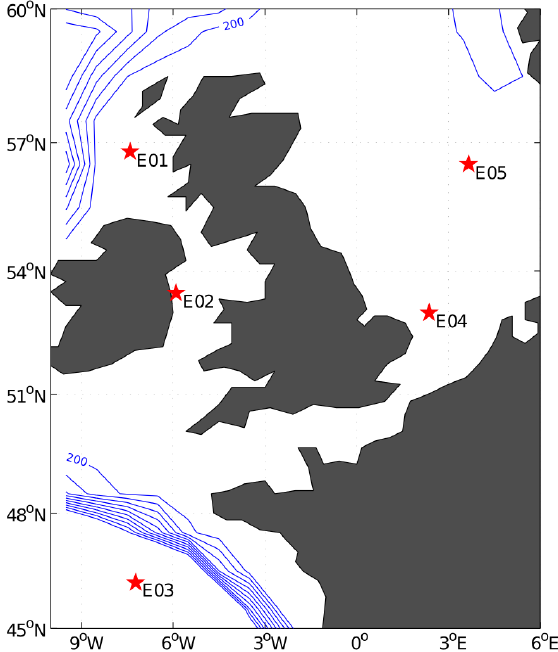
Figure 1. Map of study area showing locations of bioassay experi- ments as red stars. Blue lines are 200m depth contours.